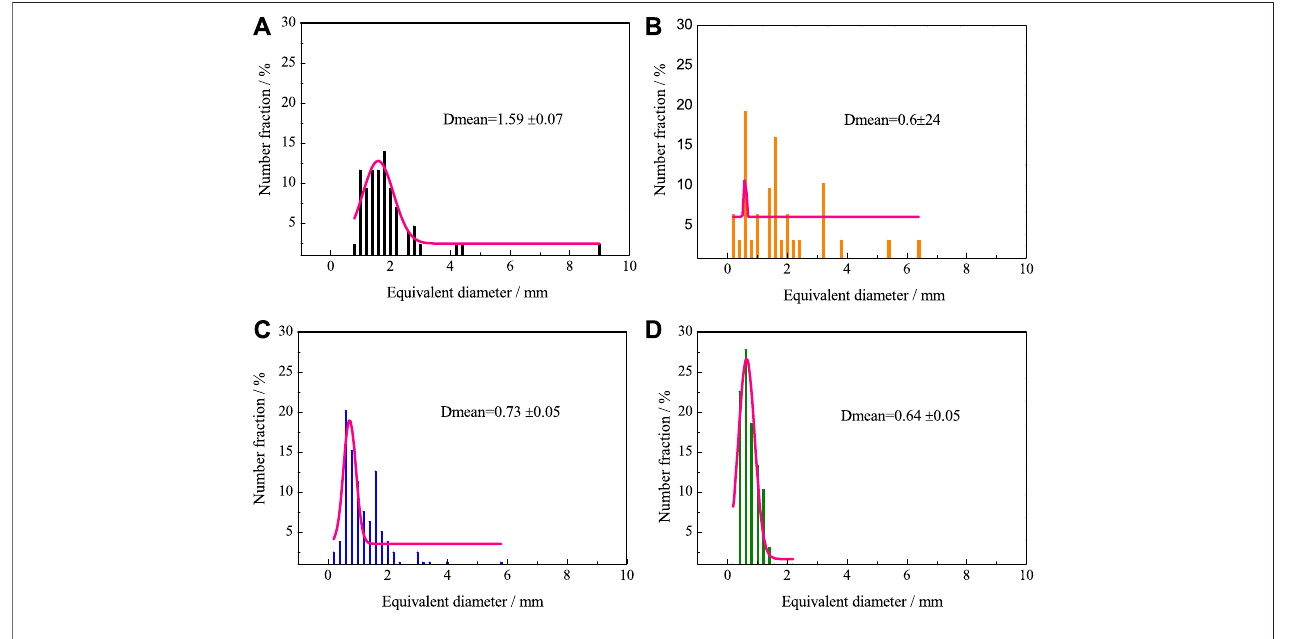
FIGURE 10 | Distribution of foam cell size in Table 4 .